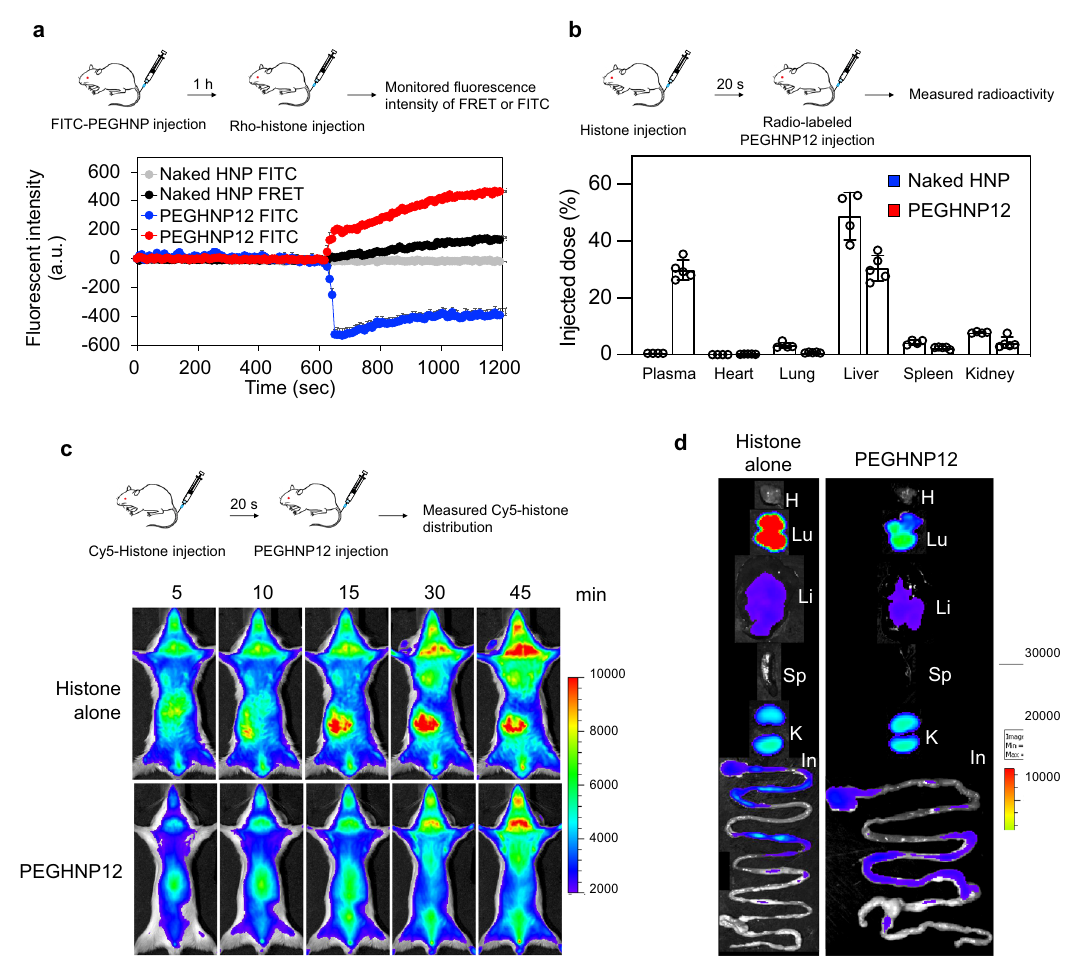
Fig. 5 Capturing histones by HNPs in the bloodstream. a Behavior of Rho – histones and FITC – PEGHNPs in the murine bloodstream was observed by laser- scanning confocal microscopy. The FITC (Ex = 488 nm, Em = 520 nm) and FRET (Ex = 488 nm, Em = 570nm) channels were recorded for 10 min before and after the histone injection. The fl uorescence intensity of FRET or FITC in the bloodstream. The zero-time point corresponds to the time of the histone injection. Data represent the means± s.d. n = 4 Rho; rhodamine, FITC fl uorescein isothiocyanate. b Biodistribution of naked HNPs and PEGHNP12 in histone pre-treated mice. Mice were intravenously injected with radio-labeled naked HNPs or PEGHNP12 at 20 s after the histone treatment (IV). Twenty- four-hour after the injection, the distribution of HNPs in the plasma and each organ was measured. Data represent the means ± s.d. n = 5. c , d Biodistribution of Cy5-histones. Mice were intravenously injected with Cy5-histone after PEGHNP12 injection. Then, the biodistribution of cy5-histones were monitored by in vivo imaging system. d Ex vivo image at 1 h after the histone injection. H heart, Lu lungs, Li liver, Sp spleen, K kidneys, In